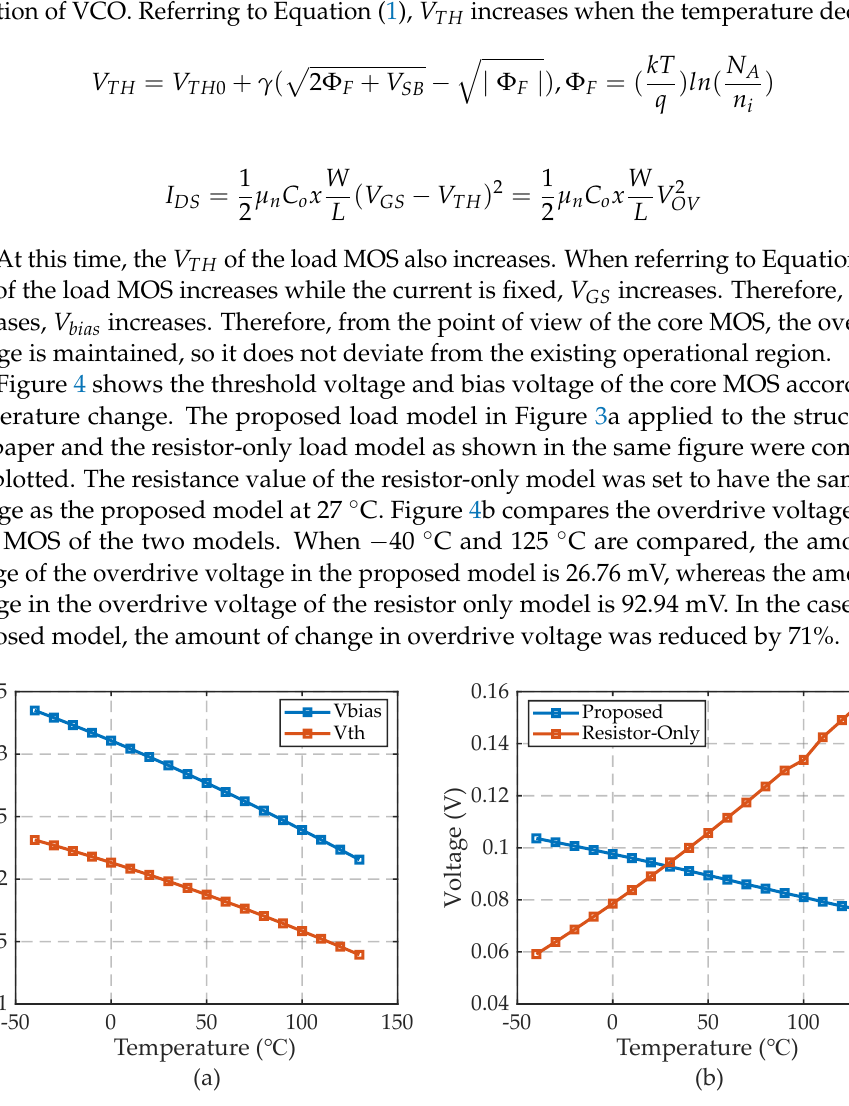
Figure 4. ( a ) Bias voltage tracking threshold voltage in proposed bias circuit and ( b ) overdrive voltages according to